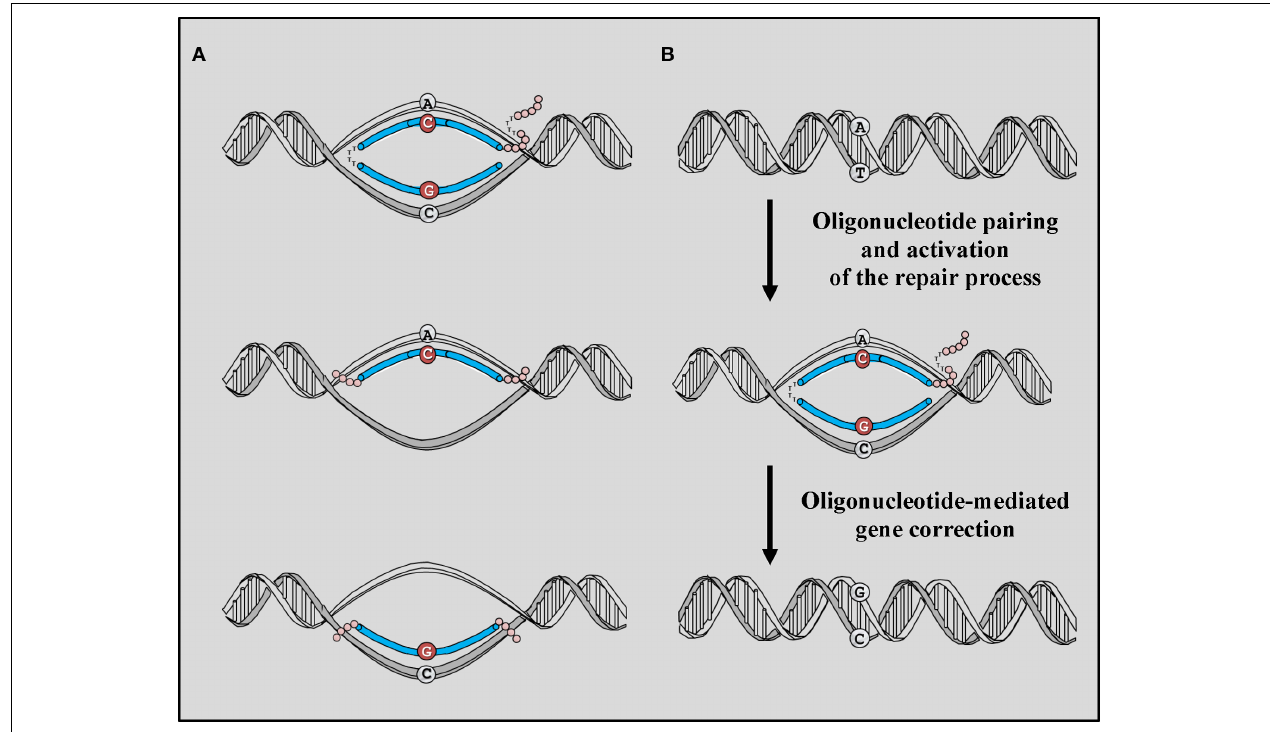
FIGURE 2 | ODN-mediated gene editing. (A) The basic structure of targeting ODNs consists of a stretch of DNA perfectly homologous to the region of the gene that is targeted for correction with the exception of a single base mismatch. A chODN contains a complimentary region composed of 2 (cid:2) -O-methyl RNA interrupted by a pentameric block of DNA bases while ssODNs consist of unmodified DNA bases and can be complimentary to the coding strand or complimentary to the non-coding strand of the gene targeted for correction. Phosphorothioate (PS) bases